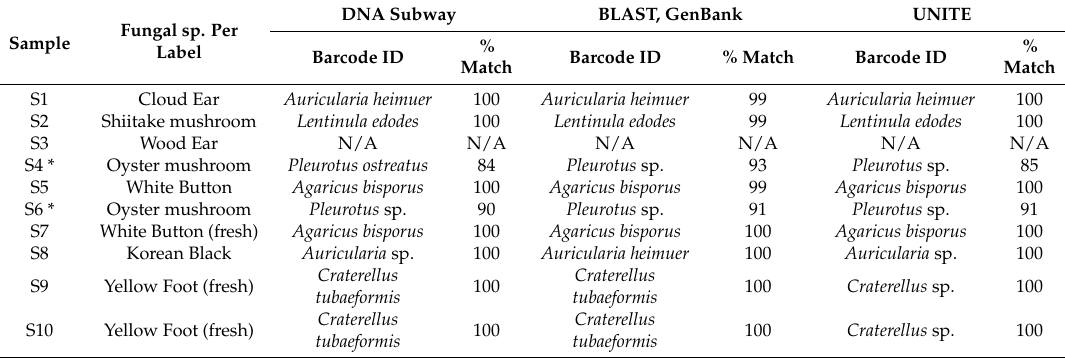
Table 2. Species identification based on internal transcribed spacer (ITS) DNA barcoding from all of the samples analyzed ( n = 10). Each consensus sequence of samples S1–S10 was subjected to three search tools to verify identity (ID), namely: 1) DNA Subway; 2) direct submission to Basic Local Alignment Search Tool (BLAST) search in GenBank; and 3) a serial BLAST search in the curated fungal taxonomic reference database User-friendly Nordic ITS Ectomycorrhiza Database (UNITE). * indicates low-quality sequences, in both instances of the Oyster mushroom samples. N/A: not available.